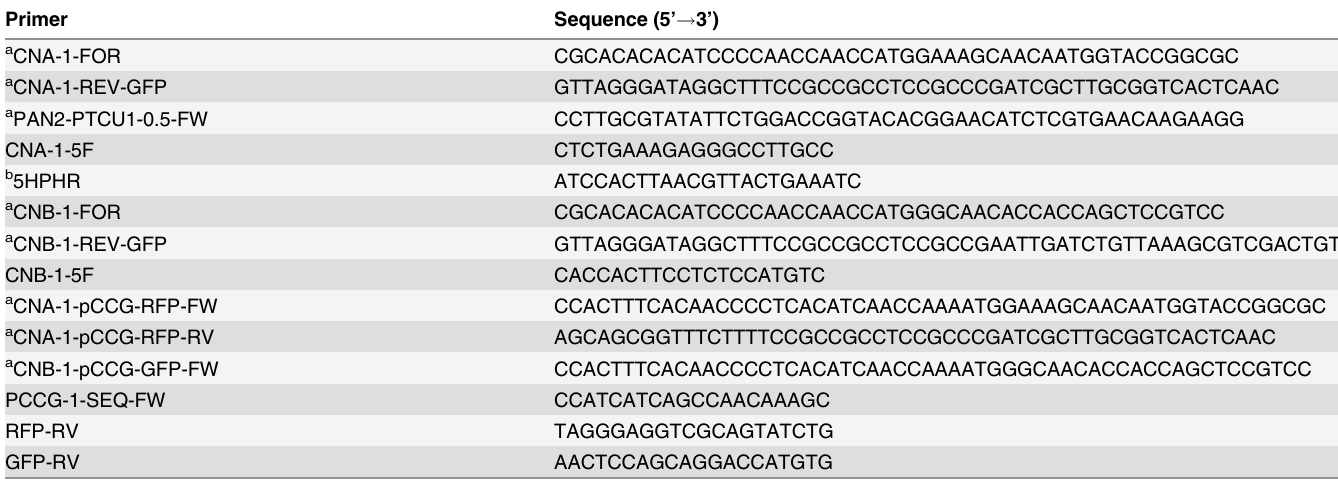
Table 2. Primers used in this